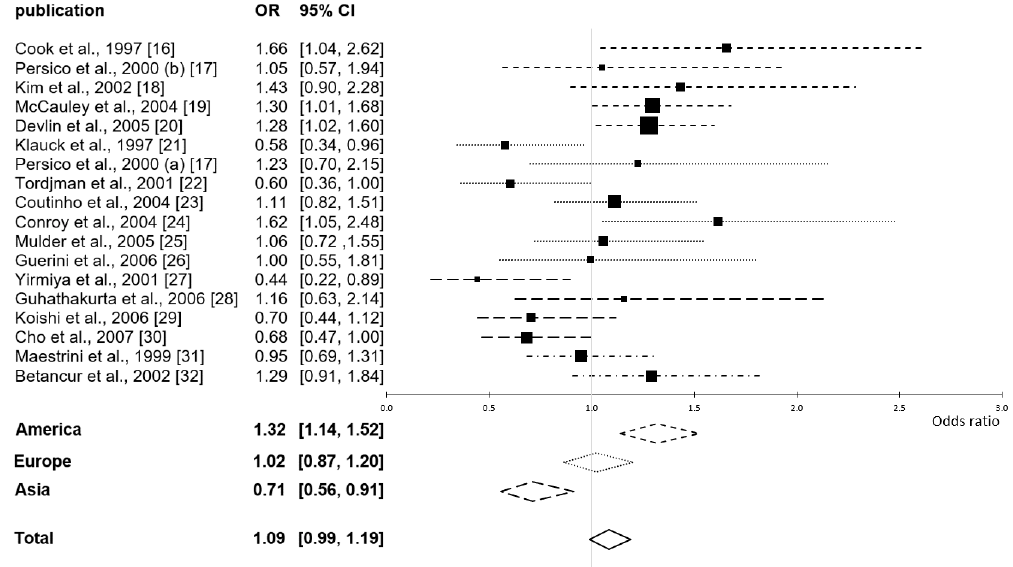
Figure 2. Forest plot of odds ratios (ORs) with 95% confidence intervals (CIs) by continent, representing the odds of transmission of the short relative to those of the long 5-HTTLPR variant, transmitted from heterozygous parents to offspring with ASD. Small dashed lines represent America, dotted lines Europe, large dashed lines Asia, and dot-dashed lines America and Europe together. Both the results of individual studies (above the horizontal axis) and the pooled results (below the horizontal axis) are shown.